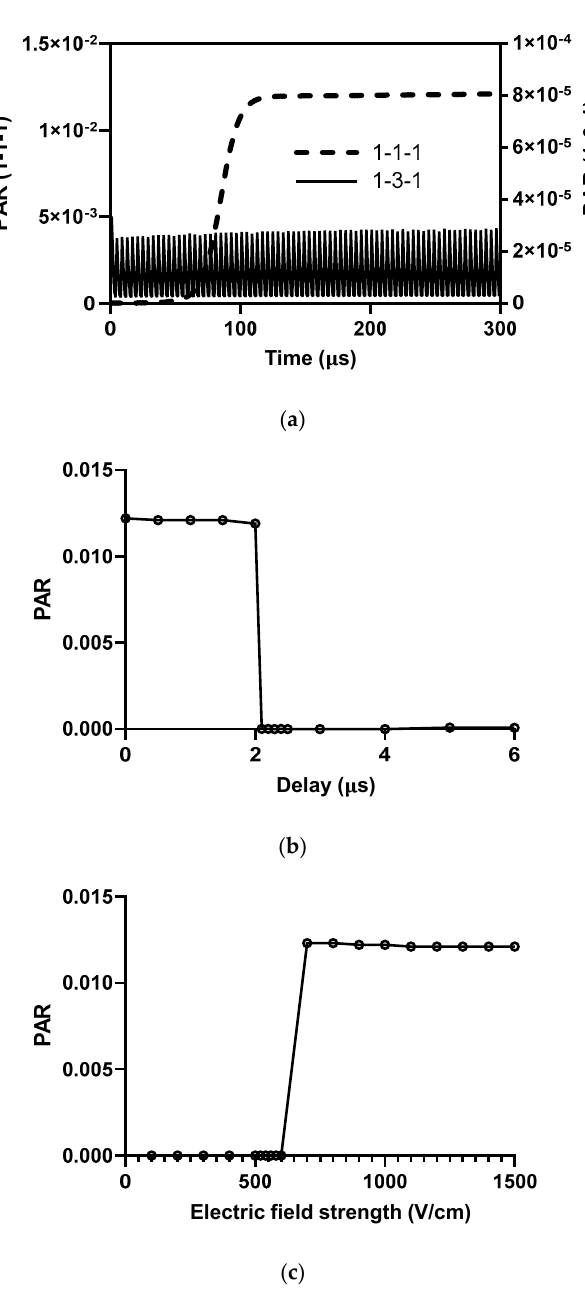
Figure 5. The change of PAR with respect to ( a ) time duration of protocols 1-1-1 and 1-3-1; the maximum of PAR with respect to ( b ) pulse delay when the pulse width is fixed at 1 µ s and the electric field strength is fixed at 1000 V/cm, and to ( c ) electric field strength when the pulse width is fixed at 1 µ s and the pulse delay is fixed at 1 µ